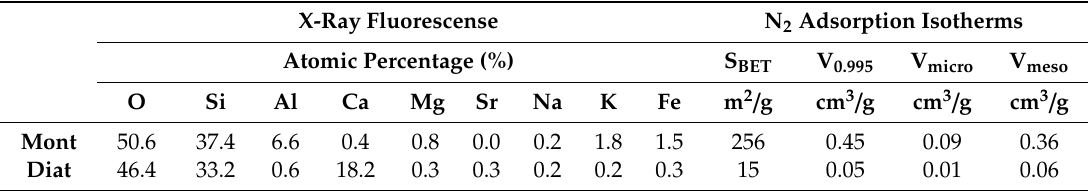
Elemental composition determined by XRF and textural parameters from N 2